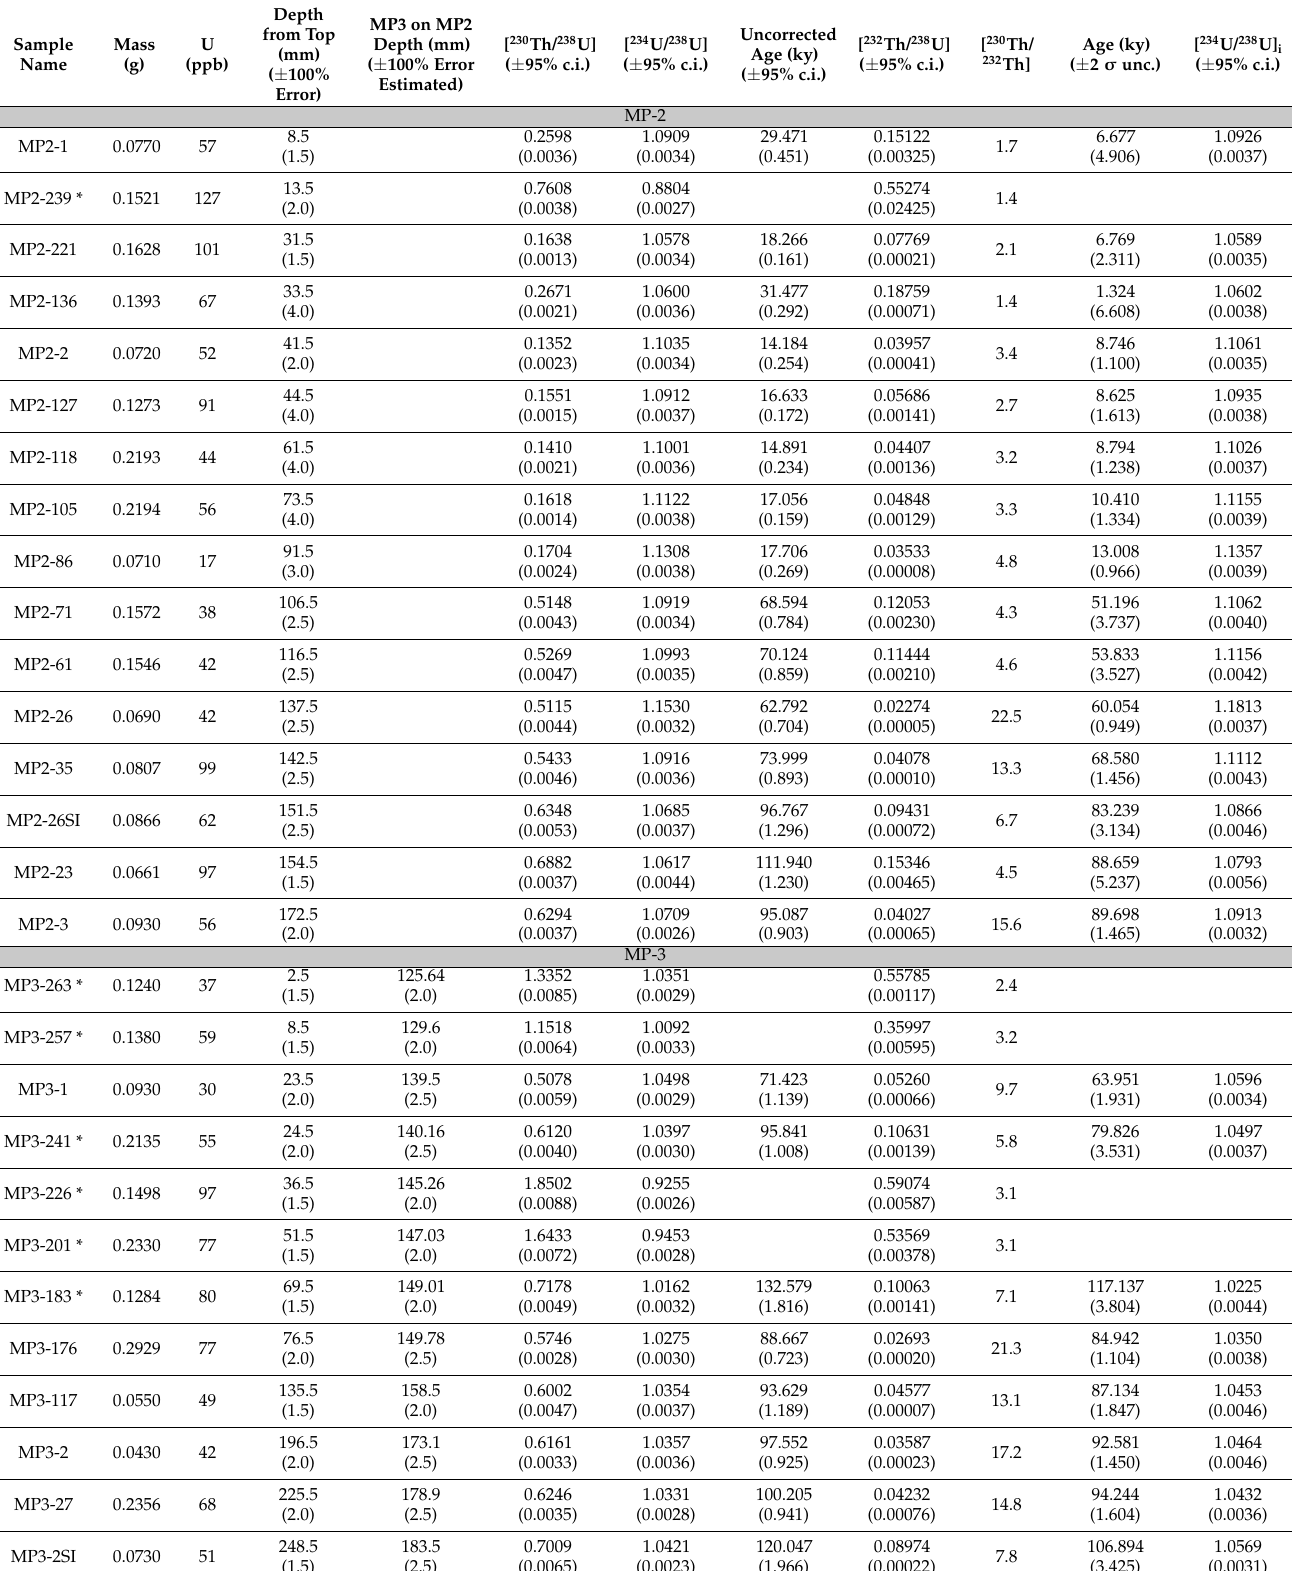
Table 1. U-Th results for the MP-2 and MP-3 stalagmites. Isotopic ratios are the activity ratios and the uncertainties are expressed as 95% confidence intervals (c.i.). Age is corrected for the initial 230 Th/ 232 Th of 1.37 ± 0.26 following the method of [66]. Results rejected from the age–depth model (outliers) are marked with a suffix